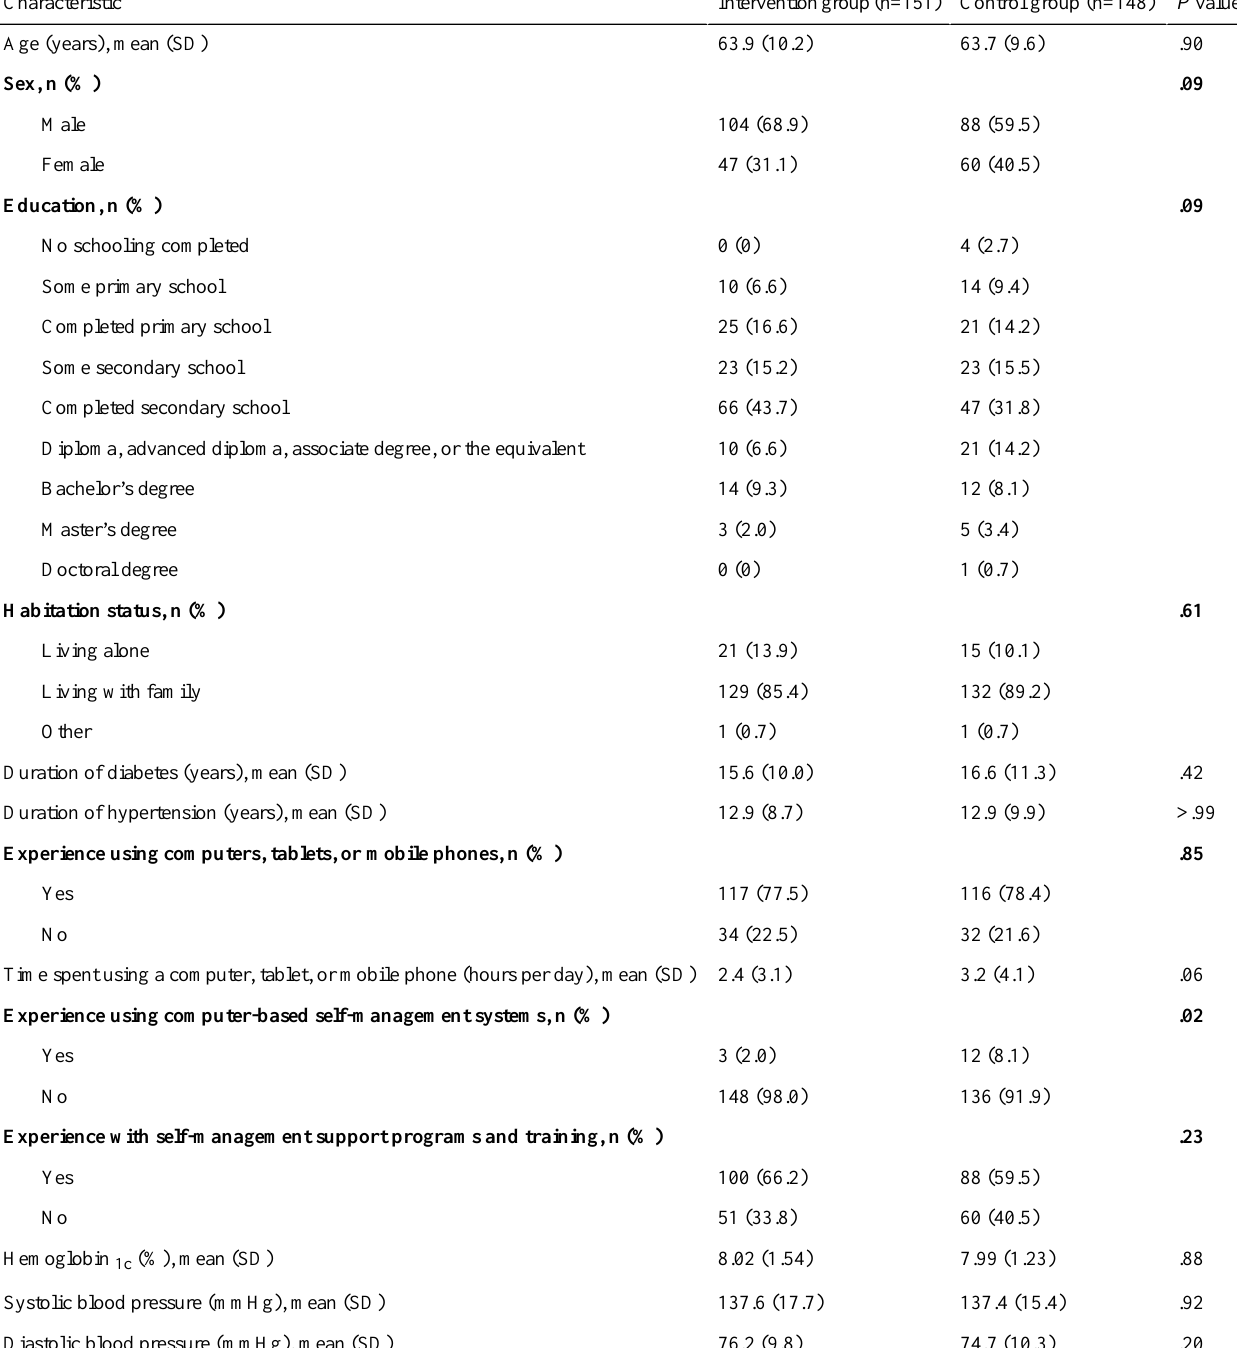
P valueControl group (n=148)Intervention group